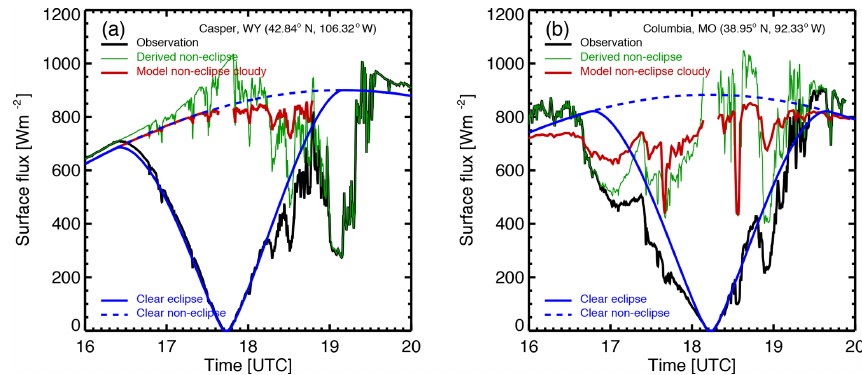
Figure 7. (a) Casper; (b) Columbia. Observed surface flux (black), derived surface SW flux for non-eclipse conditions (green), surface flux for clear atmospheric conditions for eclipse (solid blue) and non-eclipse conditions (dashed blue); the modeled surface flux (red) uses observed cloud optical depth assuming 100% cloud coverage. For the Casper site, the average reduction in local SW flux is 379Wm − 2 or 50% and the average reduction in global surface SW flux is 7.4%. For the Columbia site, the average reduction in local surface SW flux is 329Wm − 2 or 46% and the average reduction in global surface SW flux is